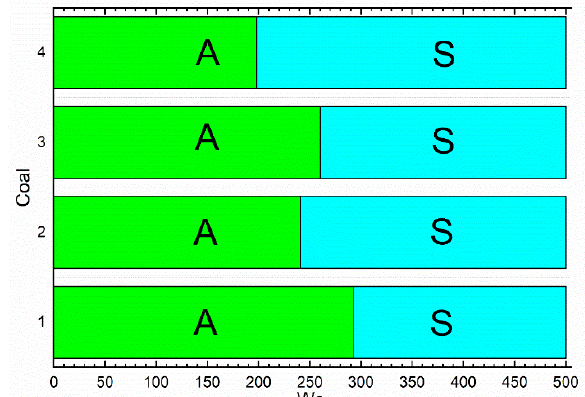
Figure 17. Interaction regime maps for distilled water droplets colliding with carbonaceous substrates when varying coal rank and substrate, R d = 1.4 mm: 1—pressed pellet from filter cake of coking coal; 2—monolithic fragment of filter cake of coking coal; 3—pressed pellet from anthracite; 4 — monolithic fragment of anthracite. A—agglomeration;